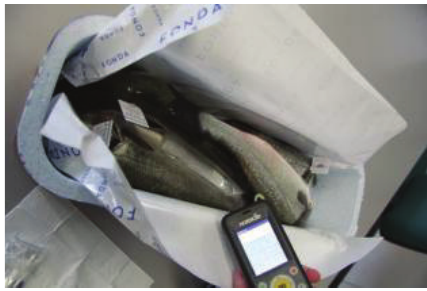
Figure 8: Read RFID data logger.